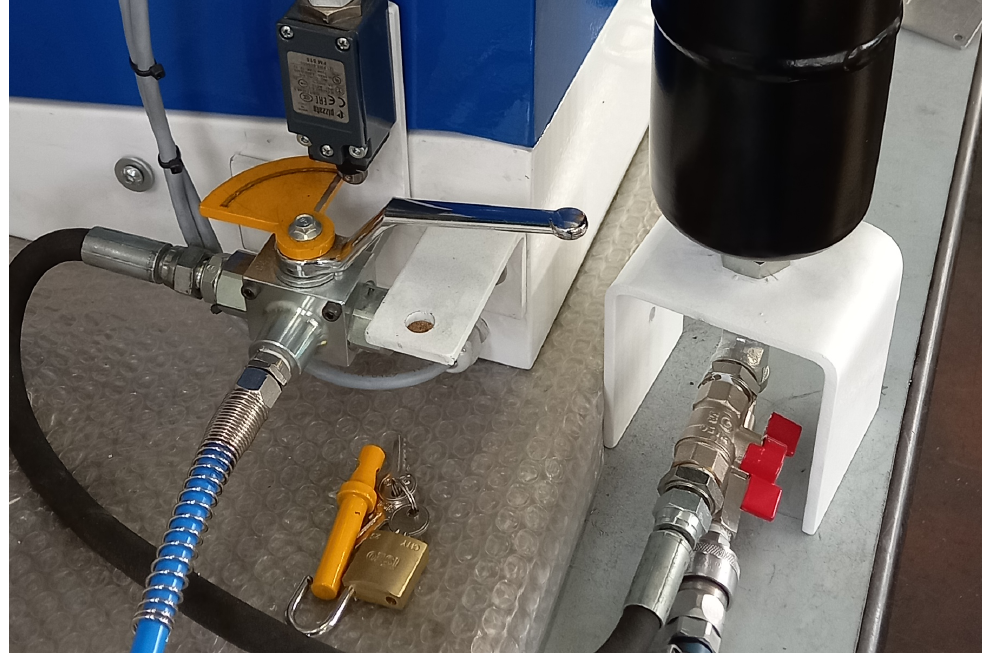
Figure 3. Part of the machinery in which a mechanical lock can be used to lock relevant energy